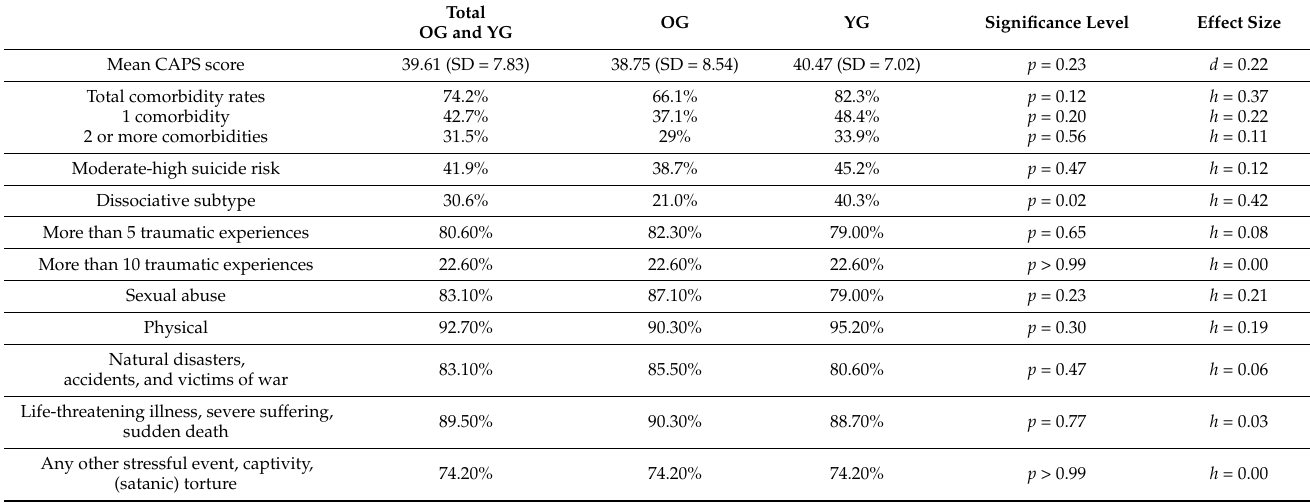
Table 2. Analyses of baseline characteristics of total, older, and younger treatment group with independent t -tests and chi-square tests.